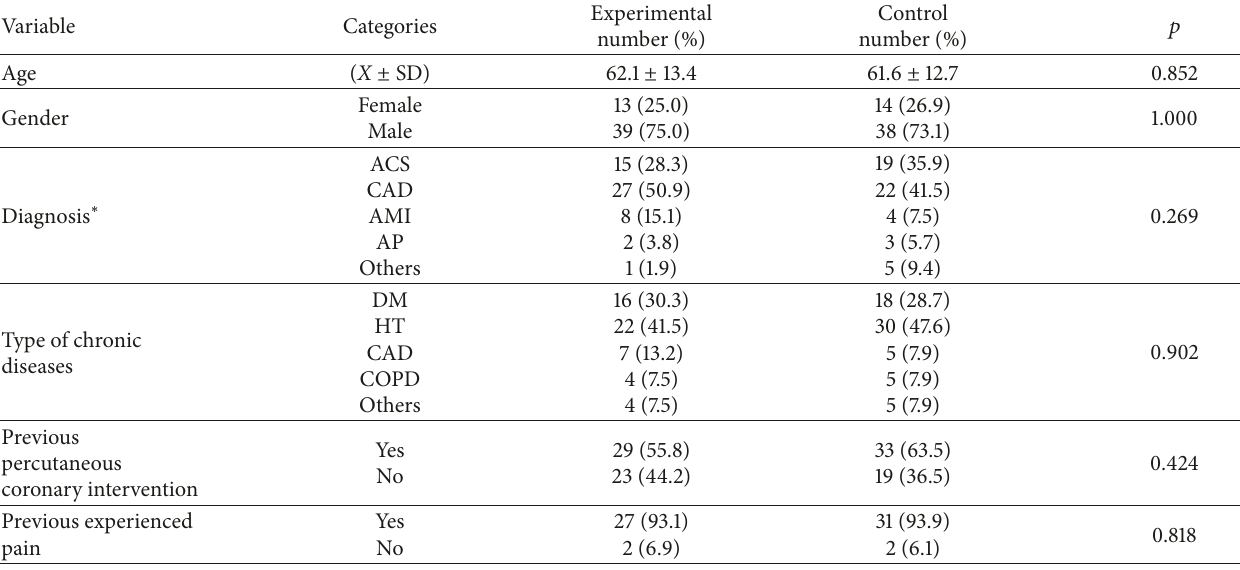
Table 2: Demographic variables of the experimental and control